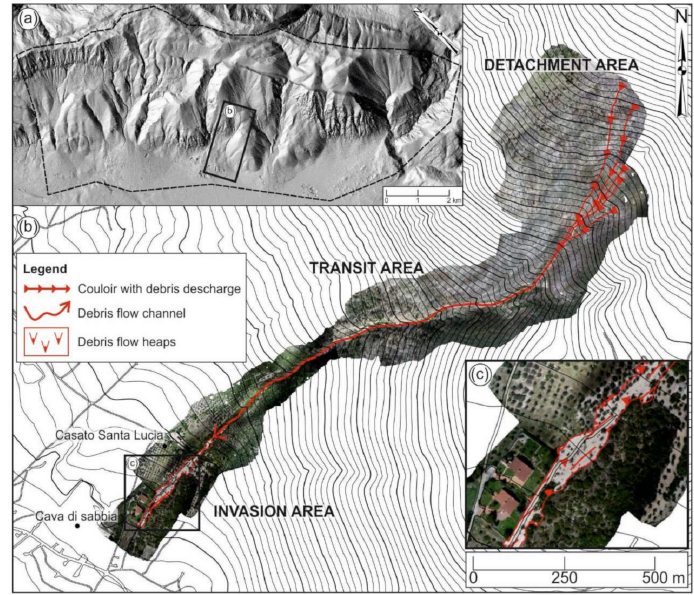
Figure 15. ( a ) Location map of the debris flow’s area; ( b ) high resolution orthophoto (mesh 25 × 25 cm) showing the debris flow event of 16 August 2018; ( c ) zoomed view of the invasion